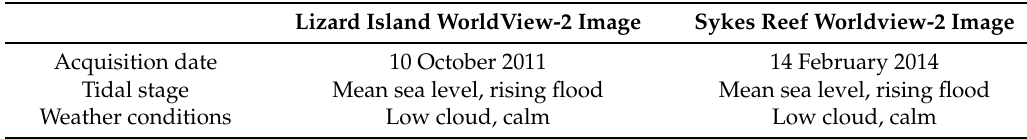
Table 2. Details of the WorldView-2 multispectral satellite images employed for bathymetry estimation using both empirical and optimization methods in this